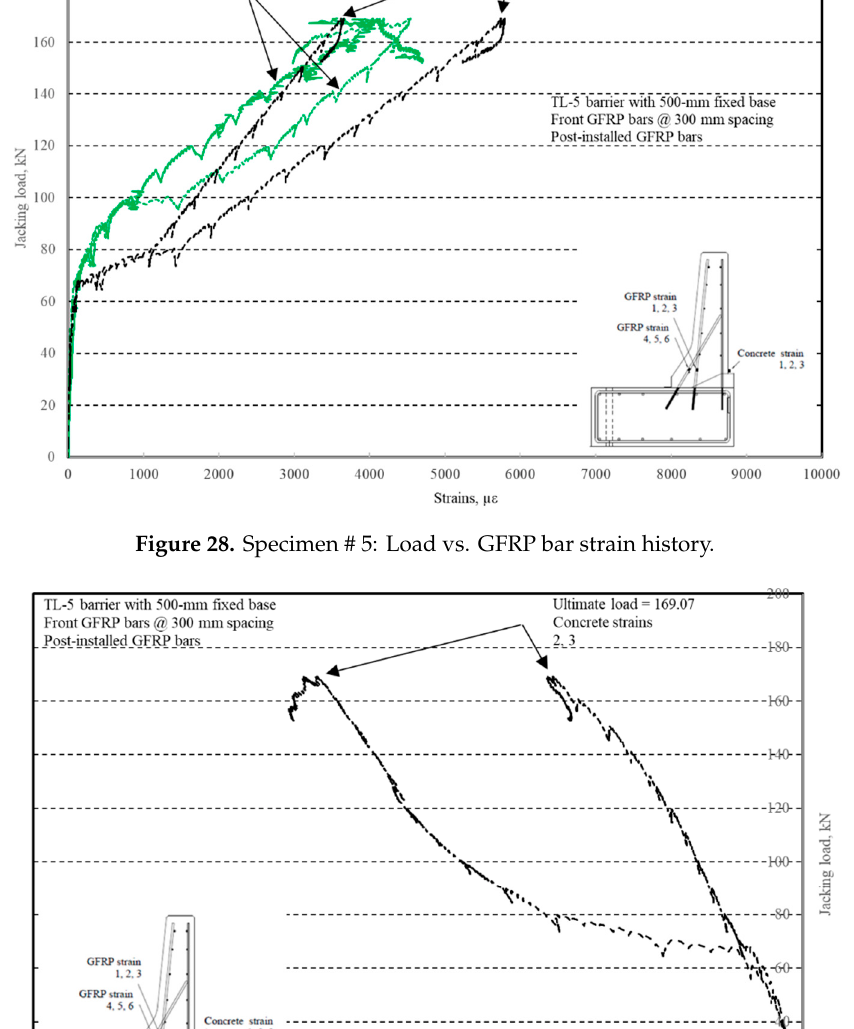
Figure 27. Specimen # 5: Load vs. displacement history.